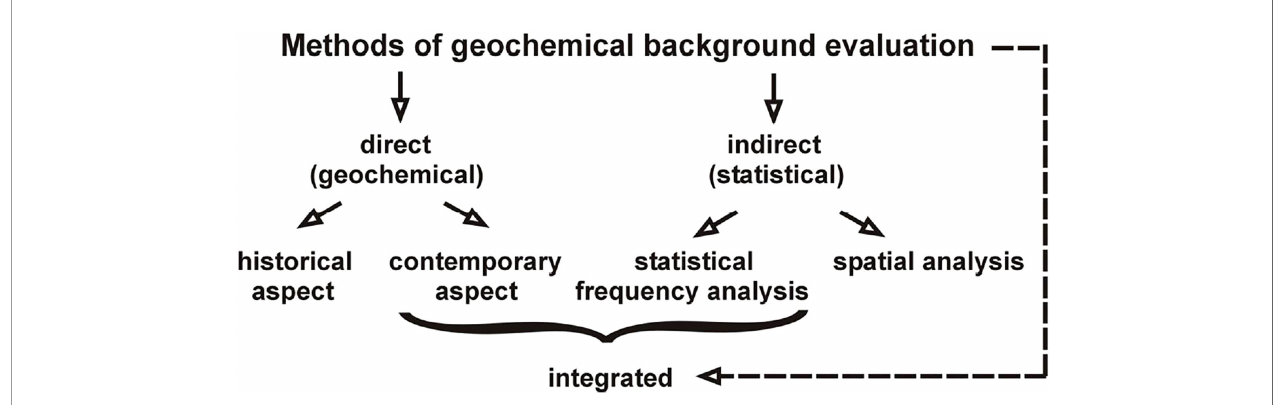
FIGURE 2 | The integrated method to determine BGVs (from Galuszka and Migaszewski,